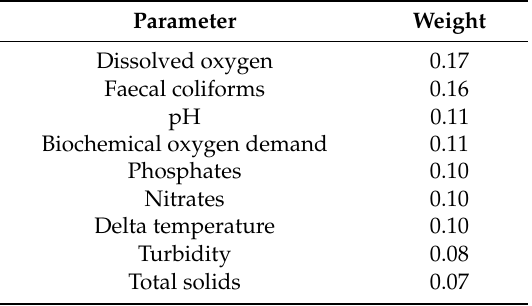
Table 2. Weighting values of parameters used to determine the National Sanitation Foundation Water Quality Index (NSF-WQI) (from Abbasi and Abbasi